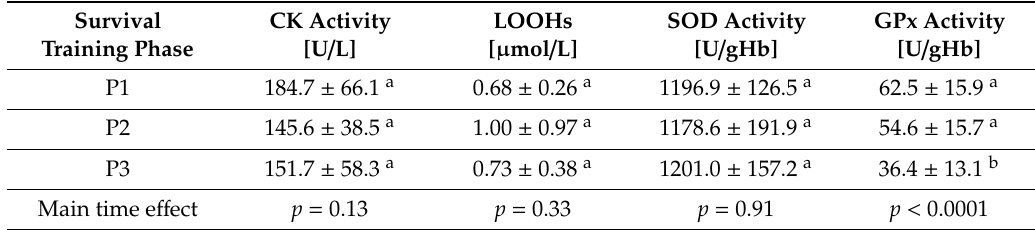
Table 1. Blood levels of the biochemical parameters in the soldiers throughout 48 h of military survival training ( n = 15).